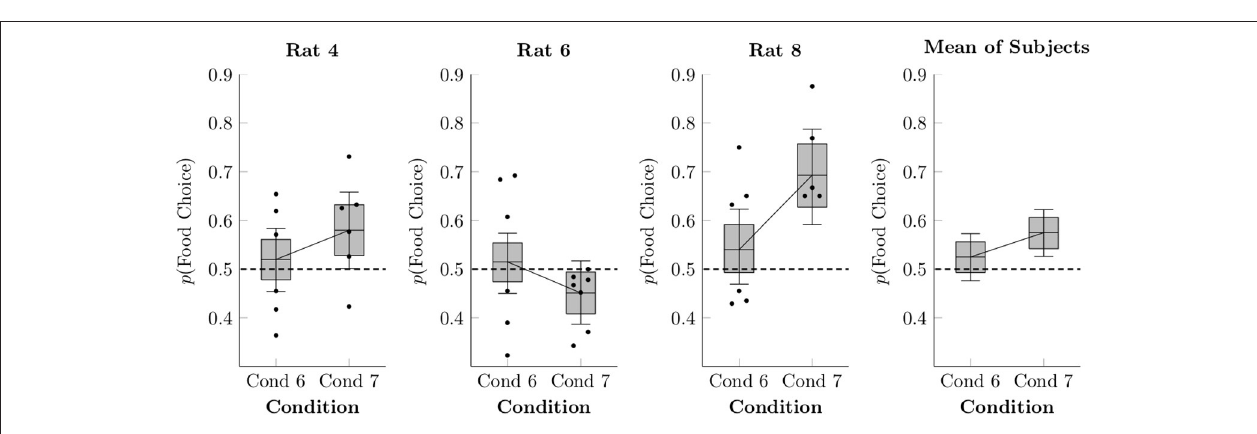
FIGURE 5 | Estimated proportion of food choices made for each of the rats in Conditions 6 and 7 based on a multi-level logistic regression, as well as observed proportions. The proportion of social choices was complementary to the food choices, such that p (cid:0) Social Choice (cid:1) = 1 − p (cid:0) Food Choice (cid:1) . Points represent observed means for each session, whereas boxes represent the 80% credible interval and whiskers represent the 95% credible interval of the estimated